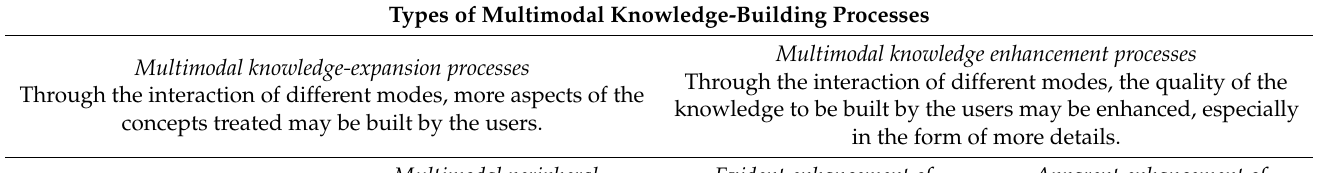
Table 1. Explanatory overview of the types of multimodal knowledge-building processes. Types of Multimodal Knowledge-Building